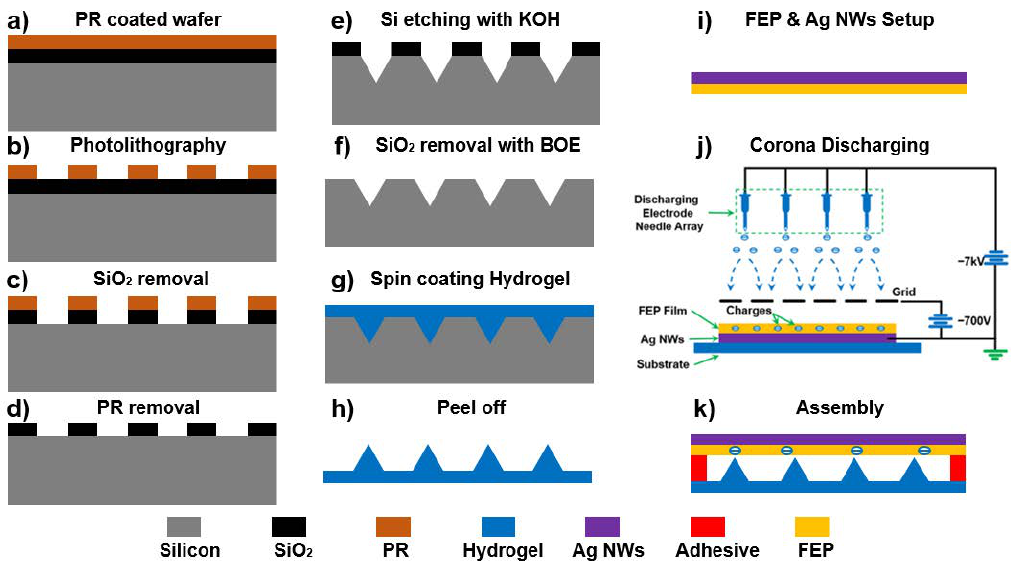
Figure 5. Fabrication of the micro-pyramidal patterned hydrogel membrane and EHTS. ( a ) The thermally oxidized Si wafer was spin-coated with Shipley1805 photoresist (PR); ( b ) PR was partial removed through photolithography; ( c ) The SiO 2 was etched in BOE plasma; ( d ) PR was completely removed; ( e ) Si etching with KOH to form the inverted pyramids array; ( f ) SiO 2 layer was removed with BOE thoroughly; ( g , h ) The micro-pyramidal patterned hydrogel film was spin-coated and peeled off; ( i ) FEP electret film and AgNWs electrode are bonded together with ethoxylate resin; ( j ) Corona discharging method is adopted to implant charge into FEP film; ( k ) EHTS was fabricated by assembled micro-pyramidal patterned hydrogel film and charged FEP & AgNWs together.